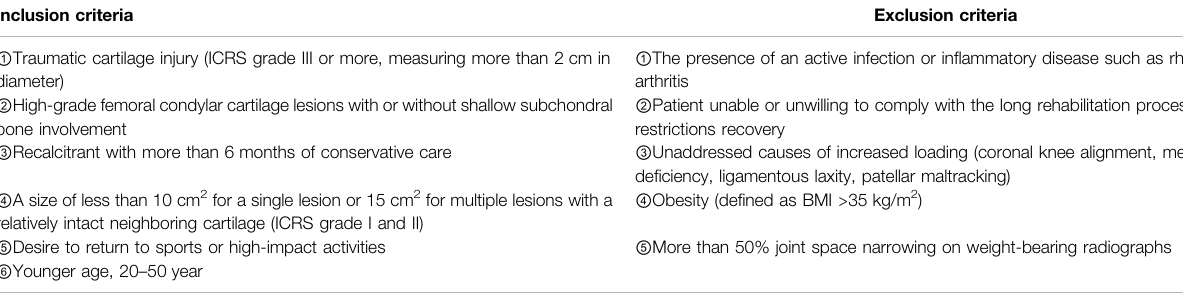
TABLE 1 | Inclusion and exclusion criteria.